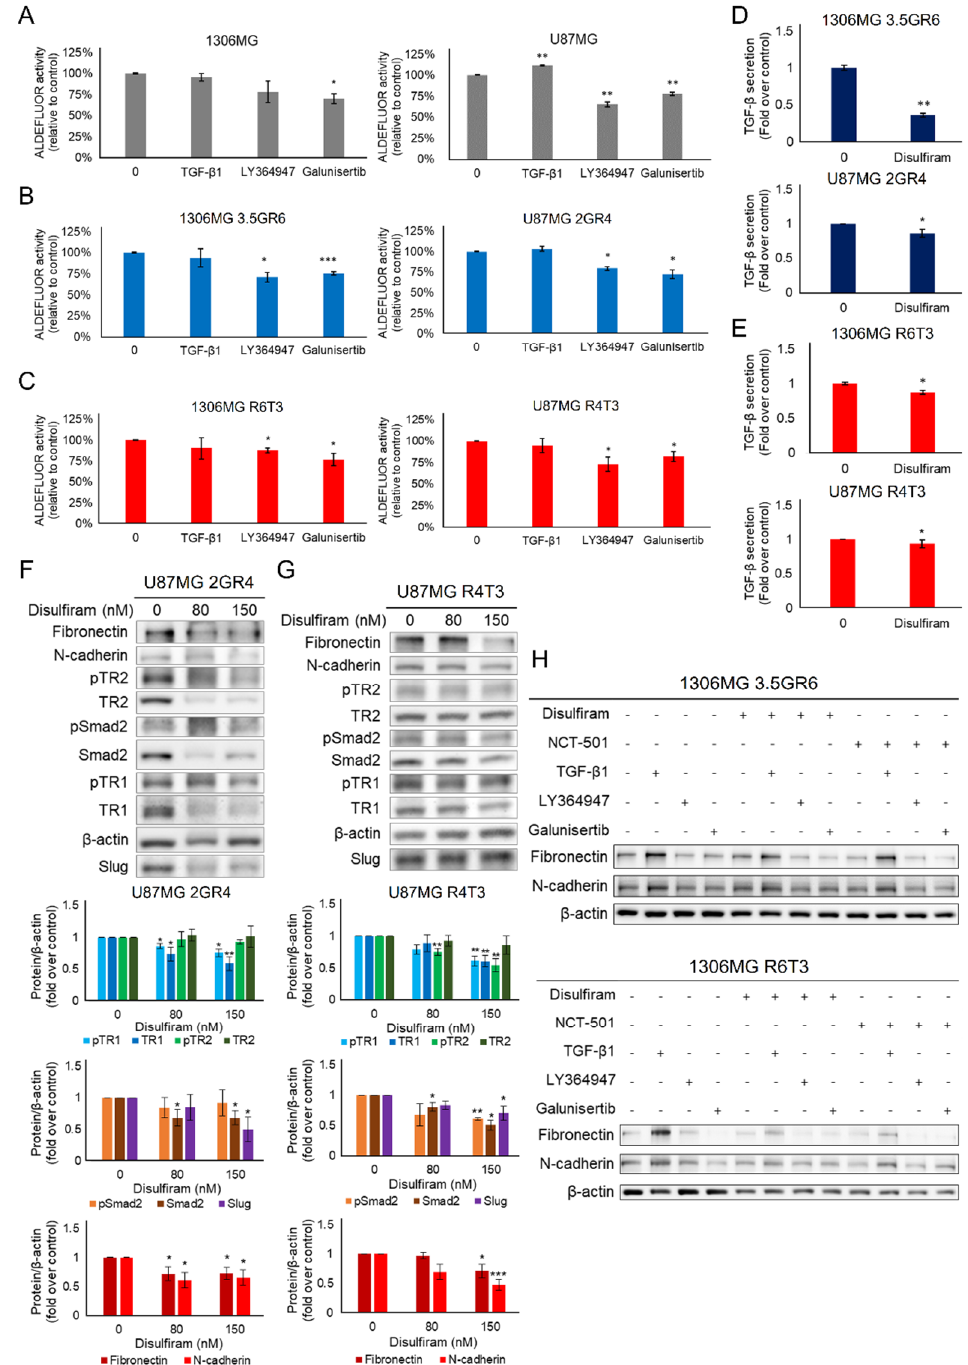
Figure 9. Blockade of ALDH by DSF suppresses TGF-β-regulated mesenchymal-like phenotype. An ALDEFLUOR assay was performed to evaluate the effects of modulating TGF-β signaling on ALDH activity. 10 ng/mL TGF-β1, 4 μM LY364947, and 100 μM Galunisertib were used to manipulate the TGF-β signaling activity. The “ + ” means with the treatment while the “ - ” means without the treatment. ( A ) Histograms showing the activity of ALDHs in parental 1306MG and U87MG; N = 4 for 1306MG; N = 3 for U87MG; ( B ) Histograms showing the activity of ALDHs in radiation-resistant 1306MG 3.5GR6 and U87MG 2GR4; N = 4 for 3.5GR6 and 2GR4; ( C ) Histograms showing the activity of ALDHs in radiation-TMZ-resistant 1306MG R6T3 and U87MG R4T3; N = 4 for R6T3; N = 5 for R4T3; ( D ) ELISA was used to measure the TGF-β secretions. 8 μM and 150 nM DSF were used to inhibit ALDHs in 1306MG and U87MG, respectively. The histograms showing TGF-β secretions in radiation-resistant 1306MG 3.5GR6 and U87MG 2GR4; N = 3 for 3.5GR6; N = 4 for 2GR4; ( E ) histo- grams showing the TGF-β secretions in radiation-TMZ-resistant 1306MG R6T3 and U87MG R4T3;